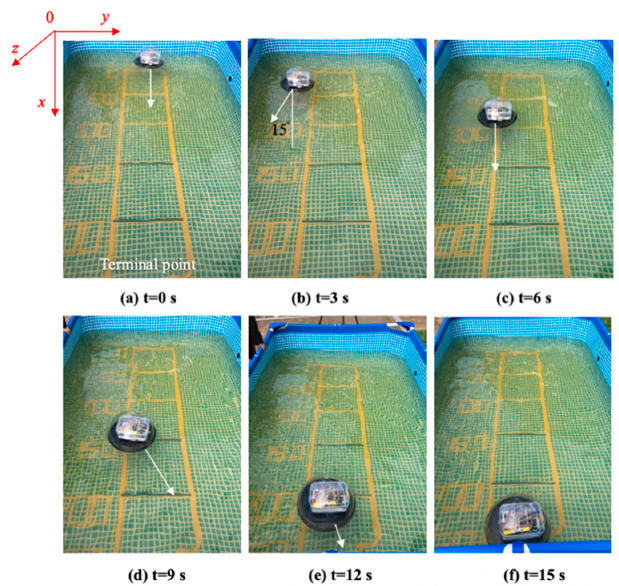
Figure 13. Stability control images of a single robot.